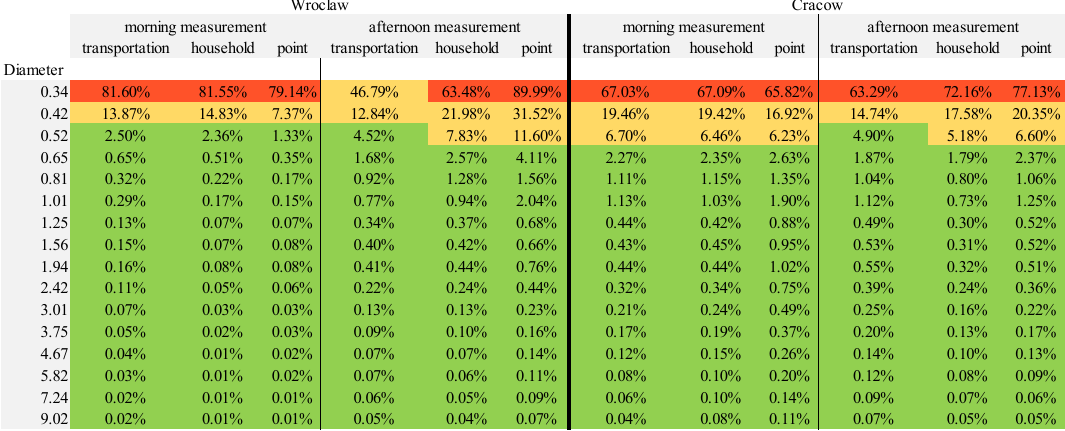
Figure 2. Percentage of particles number by their size in tests (all sectors). The next stage of the analysis was particulate mass (PM) distribution in Wroclaw and Cracow. Figure 3 presents mass distribution of particulate matter in measurement points in the Wroclaw and Cracow areas. The results obtained are presented in the form of characteristics of the particles mass concentration as a function of their diameter (dM/dlogDp). This analysis showed that particulate matter occurred throughout the whole measurement range, i.e., 0.34–10.00 μ m.